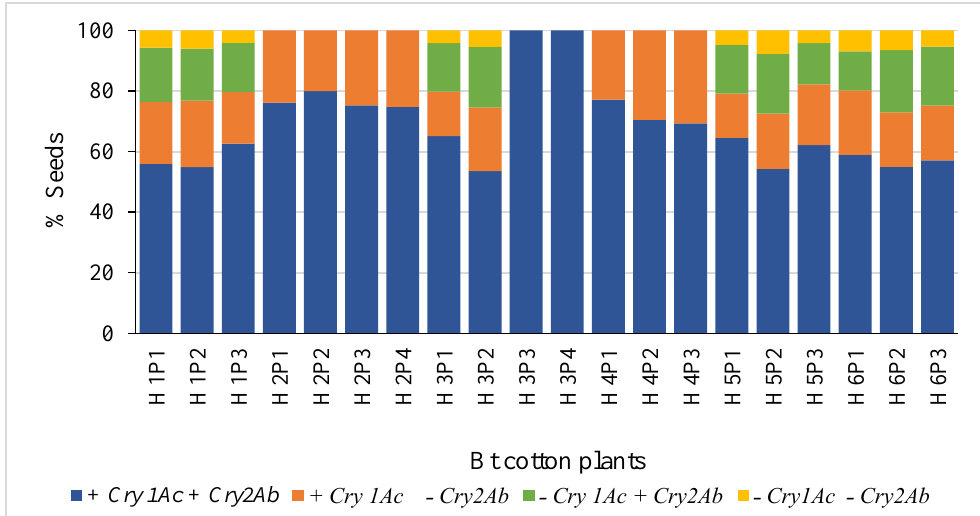
Figure 3. Plant-wise segregation of Cry genes in the seeds of Bt cotton hybrids. [H represents the Hybrid number, and P represents the plant number].